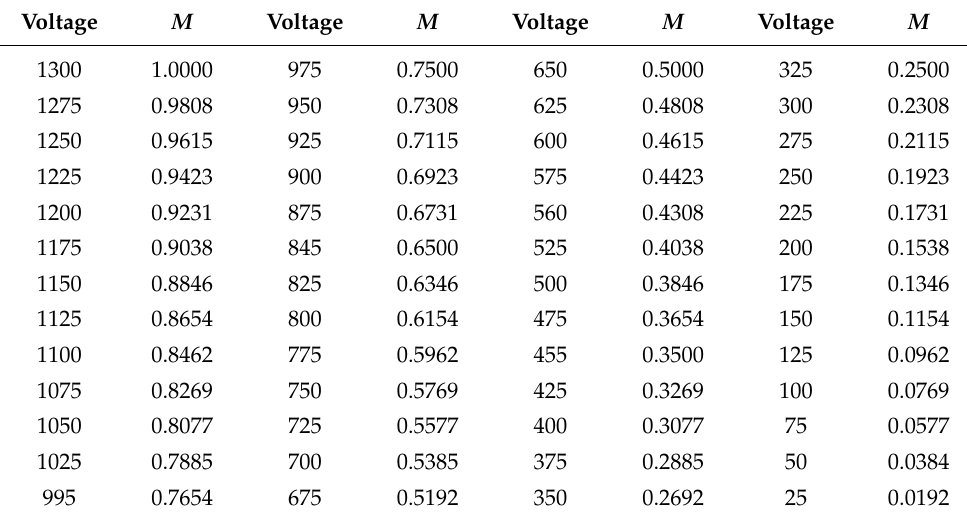
Table 3. Modulation index for voltage levels.